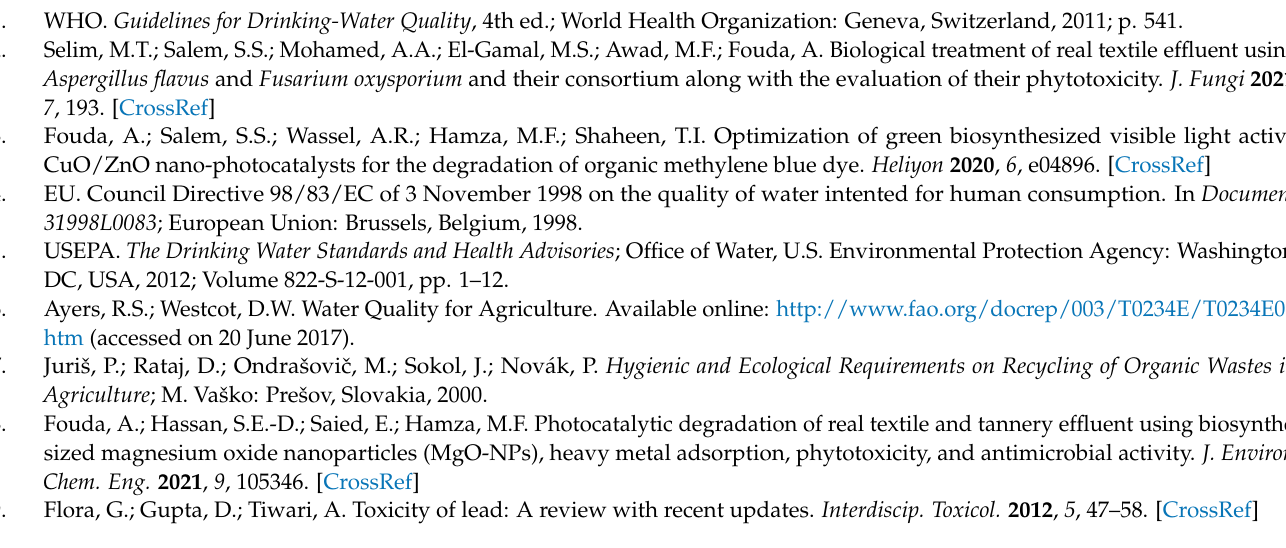
10–500 mg M L − 1 ; SD: 1 g L − 1 ; T: 23 ( ± 3) ◦ C; time: 48 h; agitation speed: 170 ( ± 3) rpm). Figure S9. Desorption efficiencies for loaded sorbent (from kinetic experiments) for Cd(II) (a) and Pb(II) (b)- using 0.2M HCl (SD: 1 g L − 1 ; T: 23 ( ± 3) ◦ C; time: 24 h; agitation speed: 170 ( ± 3) rpm). Figure S10. Sorption of Cd (solid symbols/dotted lines) and Pb (open symbols/solid lines) comparing to other elements in multi-component of mono, di, and trivalent cations (multi-component concentrations; Figure S11. Photos of the contaminant industrial areas. Figure S12. Sorption of Cd(II) (A) and Pb(II)(B) in naturally contaminated water at different pH values (SD: 1 g L − 1 ; time of agitation: 5 h; speed: 170 ( ± 3) rpm; T: 23 ± 3 ◦